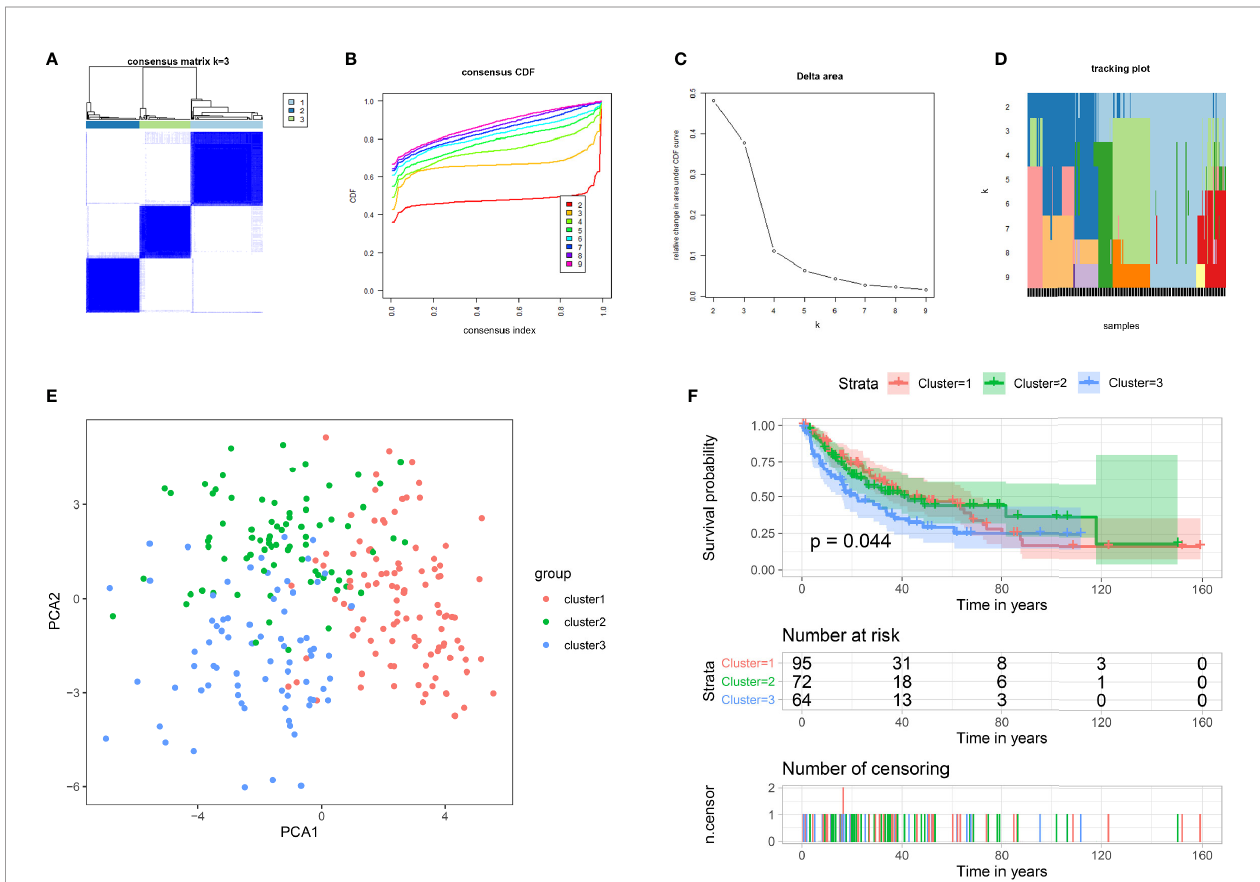
FIGURE 1 | Tumor classi fi cation and veri fi cation based on IMRGs. (A – D) Unsupervised clustering of all samples based on the IMRGs. (E) PCA based on clustering results. (F) Kaplan – Meier survival analysis of DFS in different subgroups. IMRGs, iron metabolism-related genes; PCA, principal component analysis; DFS, disease- free